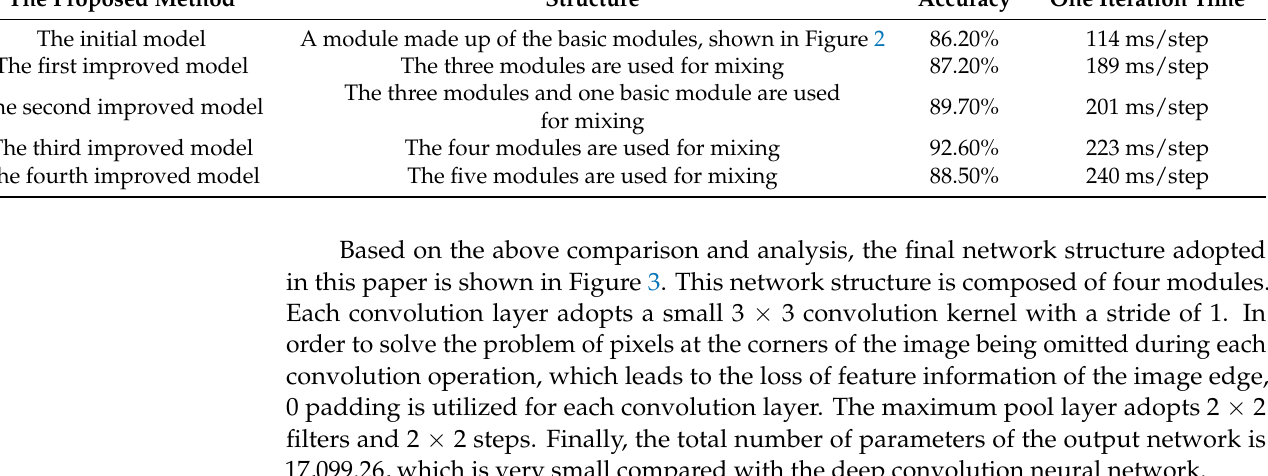
Table 1. The structures of the initial network model and some of its improved versions. The Proposed Method Structure Accuracy One Iteration Time